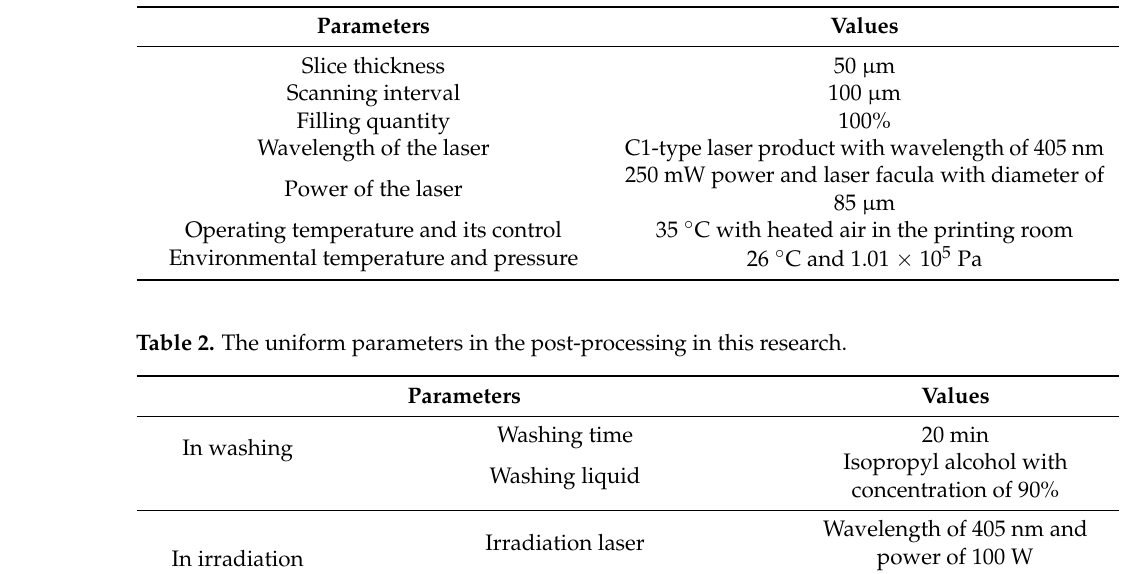
Figure 1. The apparatus for the material preparation. ( a ) Form3 low-force stereolithography 3D printer; ( b ) FormlabsForm wash; ( c ) FormlabsForm cure. Table 1. The uniform fabrication parameters in this research.